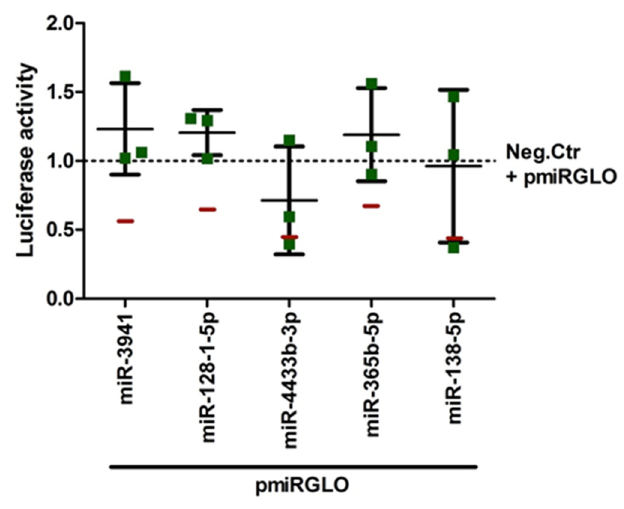
Figure 4. Regulation of empty pmiRGLO plasmid expression by selected microRNAs in HEK293T cells. The cells were transiently co-transfected with control construct and selected microRNA mimics or the negative control microRNA. Firefly/Renilla luminescence ratio showed that hsa-miR-3941, hsa-miR-128-1-5p, hsa-miR-365b-5p, and hsa-miR-138-5p did not regulate the luciferase expression of empty pmiRGLO construct (control plasmid), which show values similar to the negative control microRNA effect, so these microRNAs did not alter luciferase gene post-transcriptional regulation. Red lines representing the mean luciferase values of the pmiRGLO-3 ′ -UTR-COVID-19 plasmid after treatment with each microRNA mimic are included as reference for comparison. Graph represents the mean ± SD of, at least, three experiments performed in triplicates. An extended figure with all experimental replicate data points is available in Figure S1.